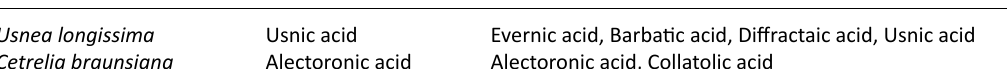
Table 1. Present acid in natural thallus and extract thallus of Usnea longissimia and Cetrelia braunsiana Lichen thallus Acids Natural thallus Thallus extract Usnea longissima Usnic acid Cetrelia braunsiana Alectoronic acid Alectoronic acid, Collatolic